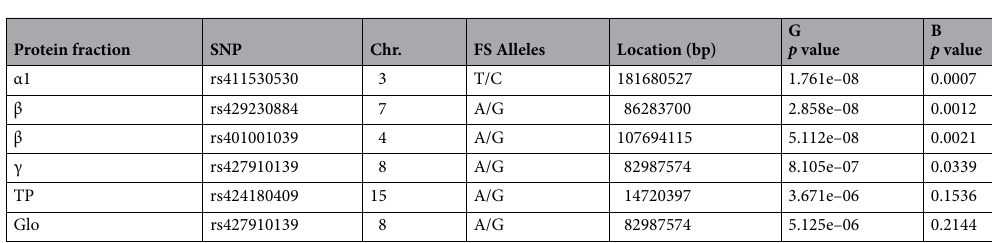
Table 1. Significant SNPs detected in genome-wide association analysis for the studied traits. α1, β, γ, TP and Glo stand for α1, β and γ globulins, total protein and globulins, respectively; Chr. is chromosome number; FS alleles are forward strand alleles; G p value and B p value are genome-wide and Bonferroni-adjusted p values, respectively; GVE is genetic variance explained by the SNP.